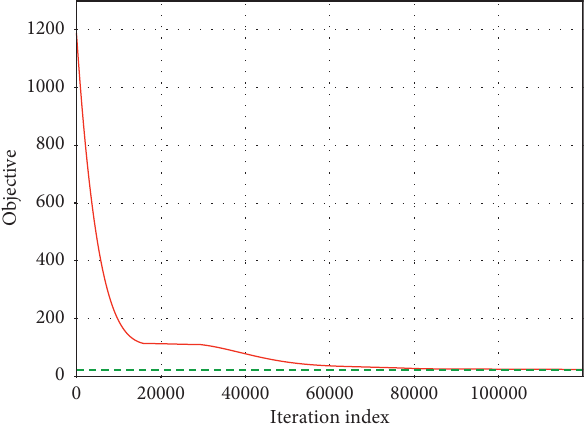
Figure 9: Iterative convergence in compass search